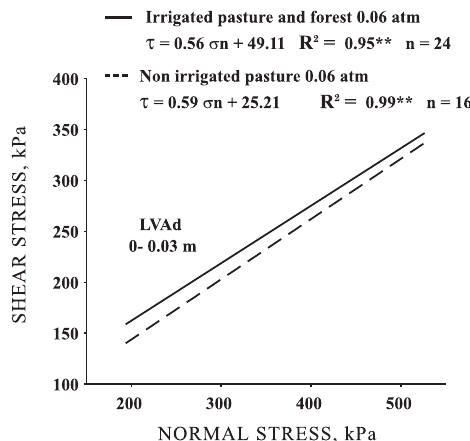
Figure 3. Rupture lines of an LVAd submitted to different managements, with samples equilibrated at a water tension at 6 kPa, result of the unification of curves obtained for the soil of irrigated pasture area and